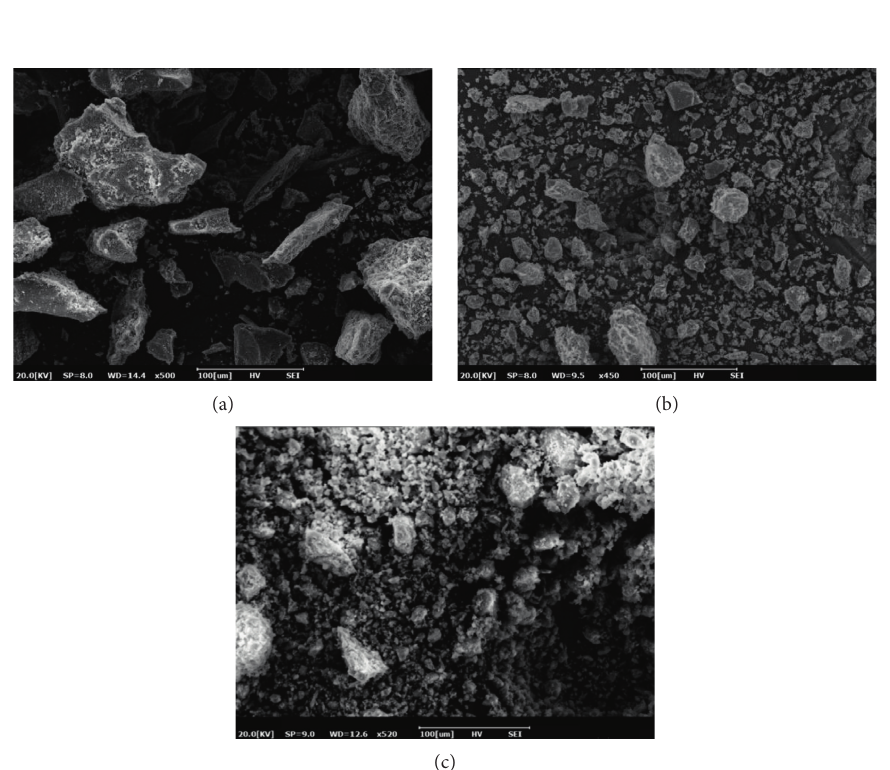
Figure 1: SEM observation of raw materials: (a) OPC; (b) SL; and (c) WS.